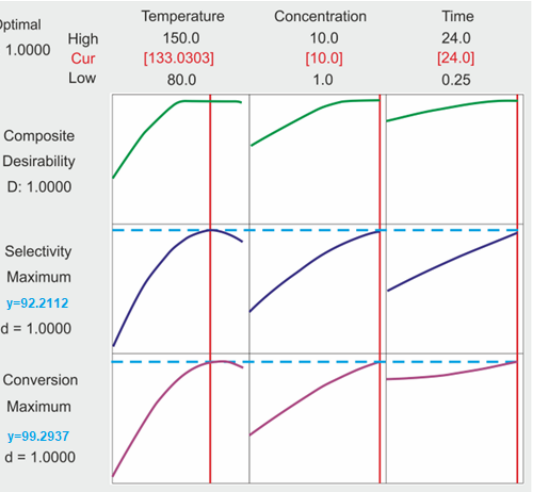
Figure 12. Combination of control parameter values at the optimal condition for all output parameters